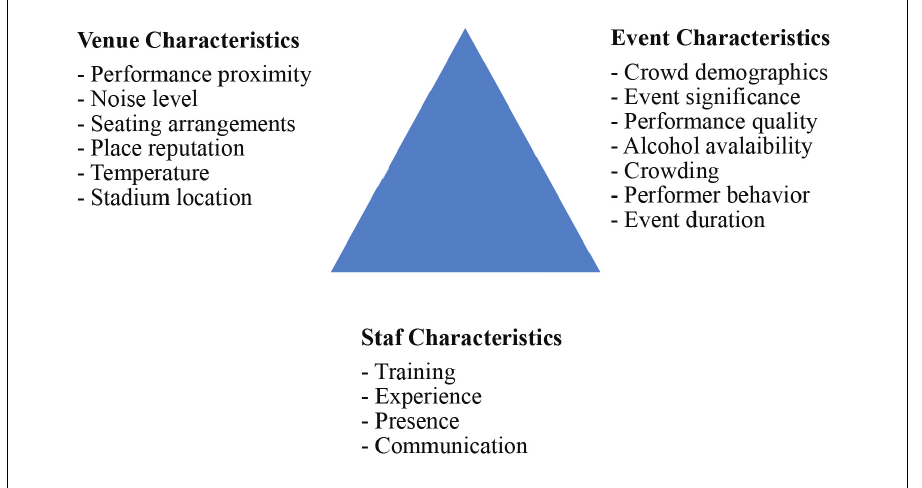
Figure 1. Spectator violence triangle and specific causes of spectator violence (Madensen & Eck,